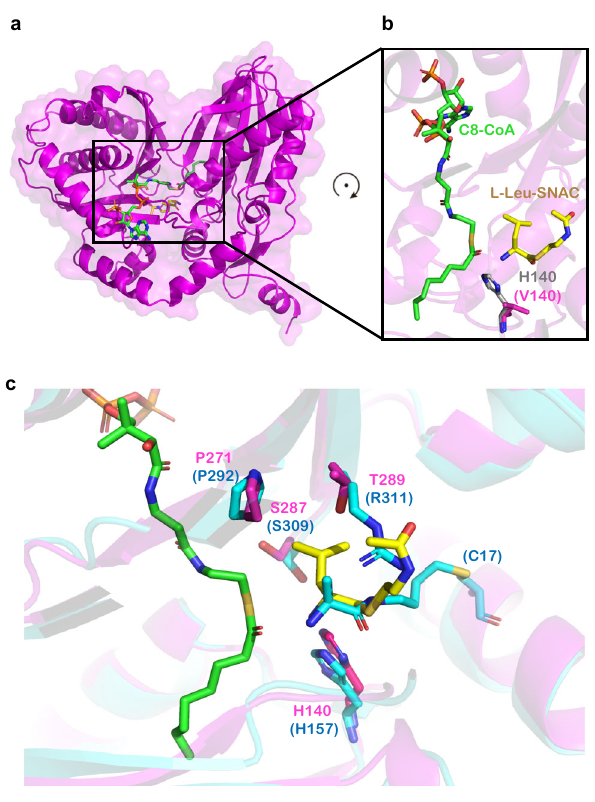
Fig. 8 Interactions between RzmA-Cs and both substrates. a Overall structure of the H140V/R148A mutant of RzmA-Cs in co-complex with C8- CoA (green) and L-Leu-SNAC (yellow). b An enlarged view around the two substrates. Valine 140 (magenta) is mutated back to histidine (white) to show its spatial position relative to the substrates. c Comparison of the L-Leu-SNAC binding site in RzmA-Cs with that of the covalent substrate mimic in the CdaPS1-Cs E17C mutant (PDB code 5DU9). Residues near the “ acceptor ” substrates in RzmA and CdaPS1 are labeled in magenta and blue,